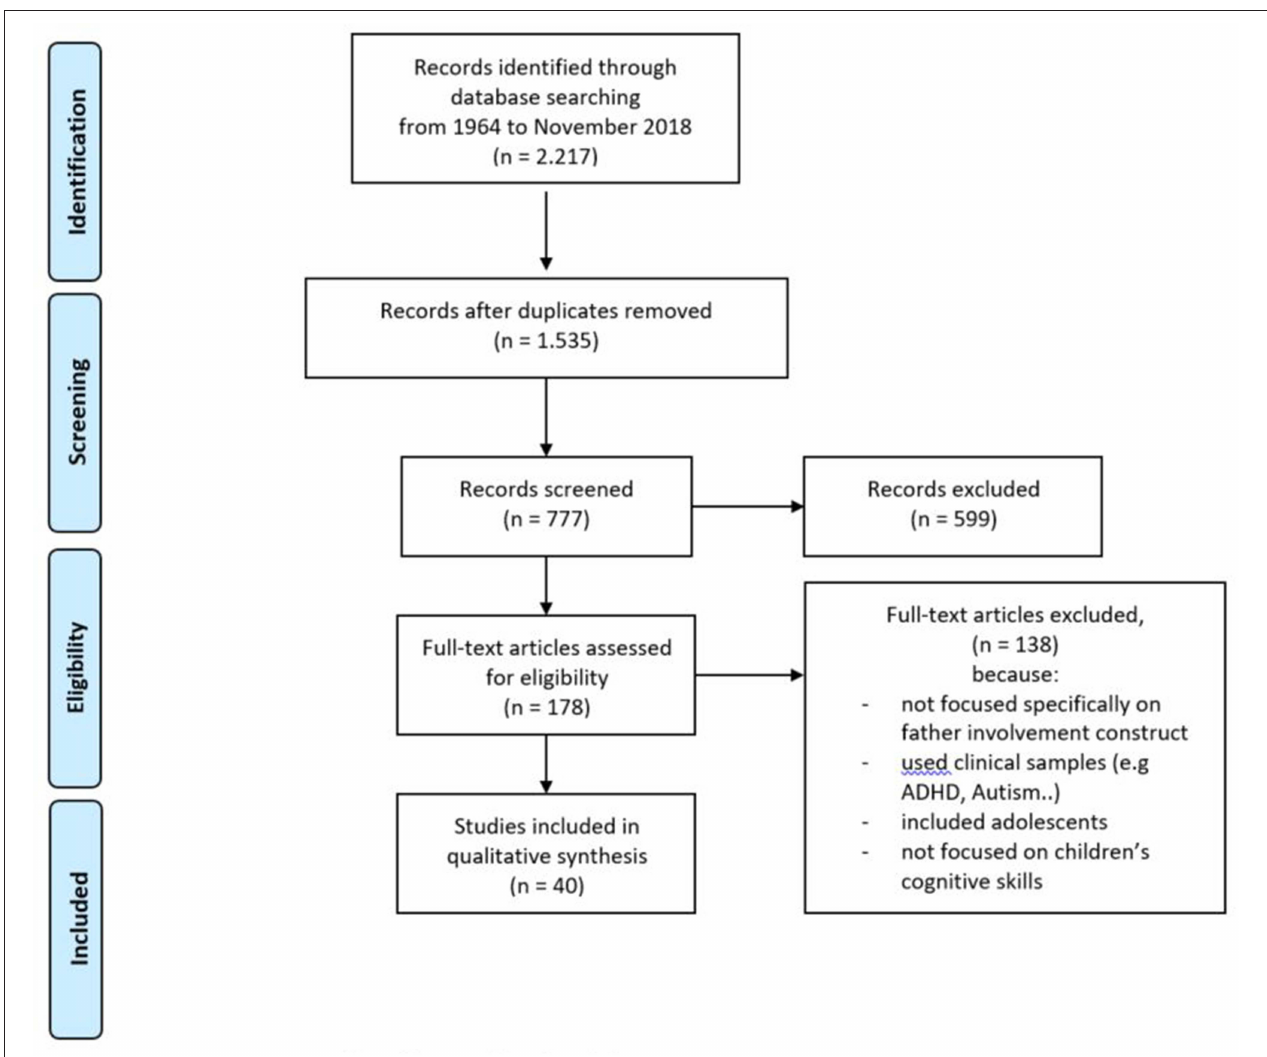
FIGURE 1 | PRISMA flow diagram of study